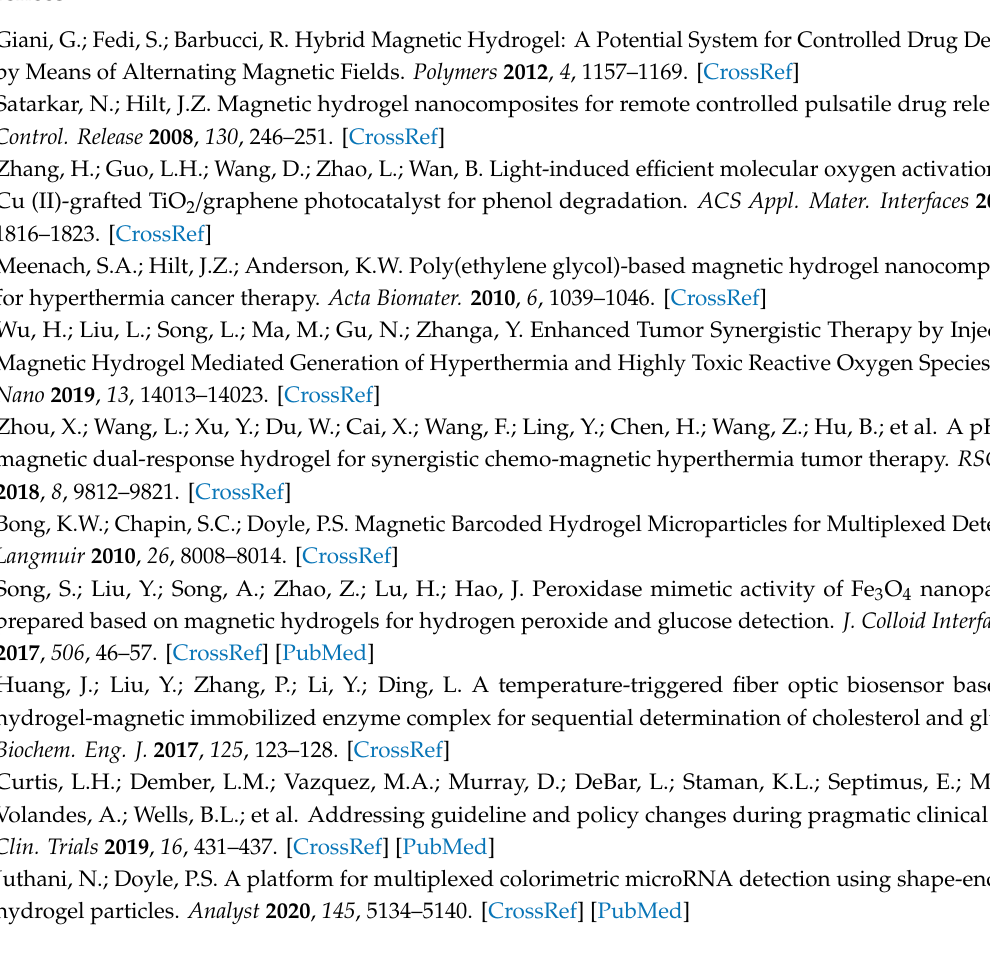
software. A circularity of 1.0 represents a perfect spherical morphology, Figure S3: Magnetic hydrogels embedding 5 mg / mL of MNP concentration synthesized with LAP and a circularity histogram of the microparticles, Figure S4: Dot plots of fluorescence intensity of individual magnetic hydrogels synthesized with either Darocur 1173 or LAP. Twenty microparticles for each photoinitiator were measured via the ImageJ software, Figure S5: VSM measurement results. M–H curves of freeze-dried MNPs (left) and magnetic hydrogels (right). The concentration of magnetic hydrogels before drying was 4 mg Fe / mL. M versus 1 / B and a linearly fitted line at a magnetic field from 0.2 to 0.5 T are presented in each graph, Figure S6: Comparative absorbance spectra of free MNPs (red) and magnetic hydrogels (black) mixed with ABTS. Each solution contains 160 µ L of sodium acetate bu ff er (0.2 M, pH 4.0), 20 µ L of ABTS (60 mM), and 20 µ L of free MNPs or magnetic hydrogels (0.2 Fe mg / mL), and the external magnetic field was applied for 10 s before the measurement, Figure S7: Comparative catalytic activity of freeze-dried magnetic hydrogels after rehydration with DI water. Hydrogels (20 µ L, 0.2 Fe mg / mL) was incubated with ABTS (20 µ L, 60 mM) and H 2 O 2 (20 µ L, 5 mM) in sodium acetate bu ff er (0.2 M, pH of 4.0). Absorbance at 417 nm was used to calculate the catalytic activity, Figure S8: Absorbance spectra for dose-responsive glucose detection by magnetic hydrogels with